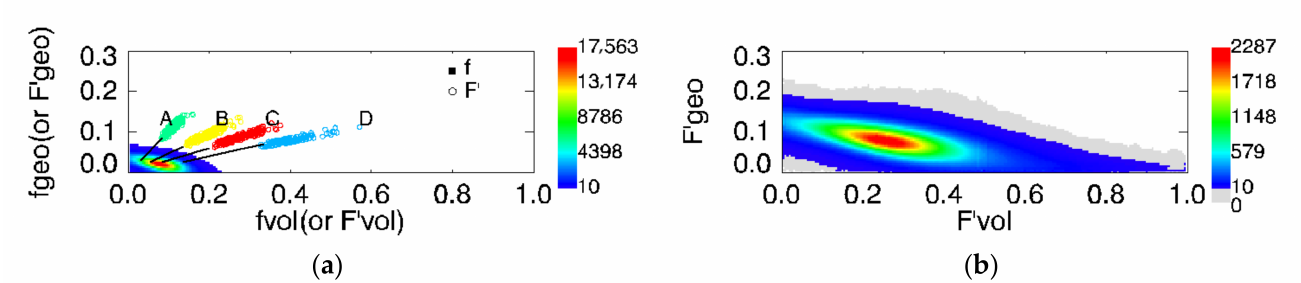
Figure 3. The scatter diagrams of original ( a ) and normalized ( b ) volumetric and geometric scatter parameters of tile h12v04 on DOY 170, 2010 in shortwave band (b10). The color represents the number of pixels in each grid. The open circles in ( a ) refer to the distribution of the normalized model parameters in the statistic grid A–D (black circles) of the original